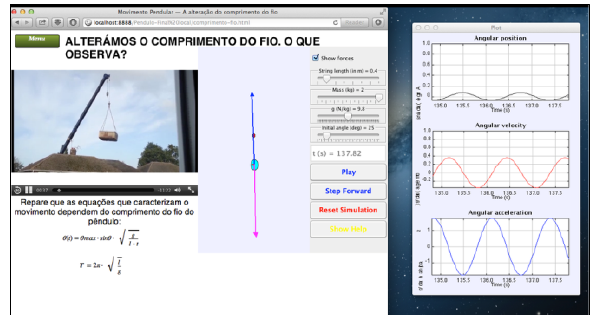
Figure 3. Interactive video for the gravity pendulum.